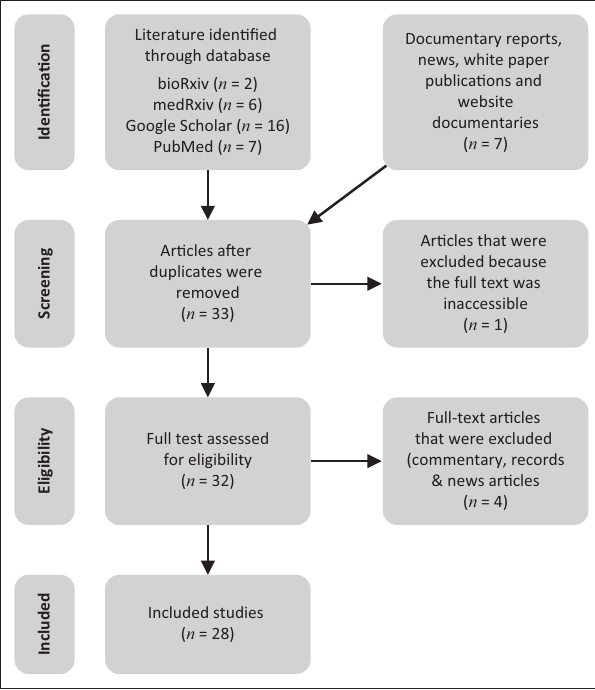
FIGURE 2: PRISMA flow diagram showing the scoping review process.